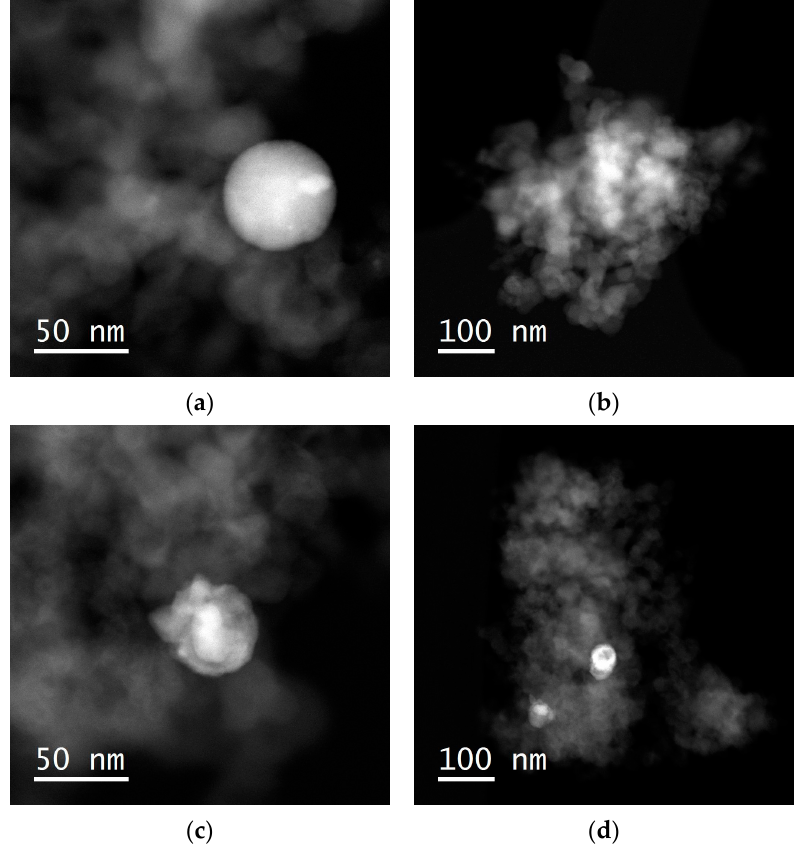
Figure 4. ( a – d ). Selected HAADF-STEM images of the catalytically active composite CoCorrPPh 3 @Vulcan-800.